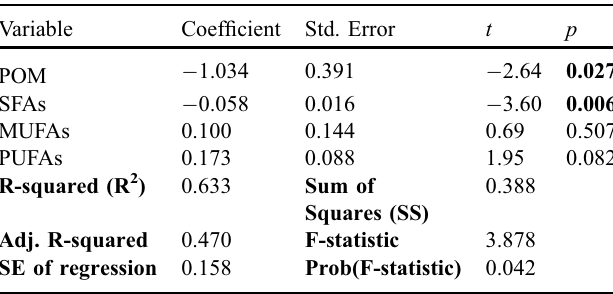
Table 1. Summary statistics of the multiple linear regression analyses explaining the variation of juvenile drifting according to the trophic parameters of nearshore waters (particulate organic matter: POM; saturated: SFA; monounsaturated: MUFA; and polyunsaturated fatty acids: PUFA).